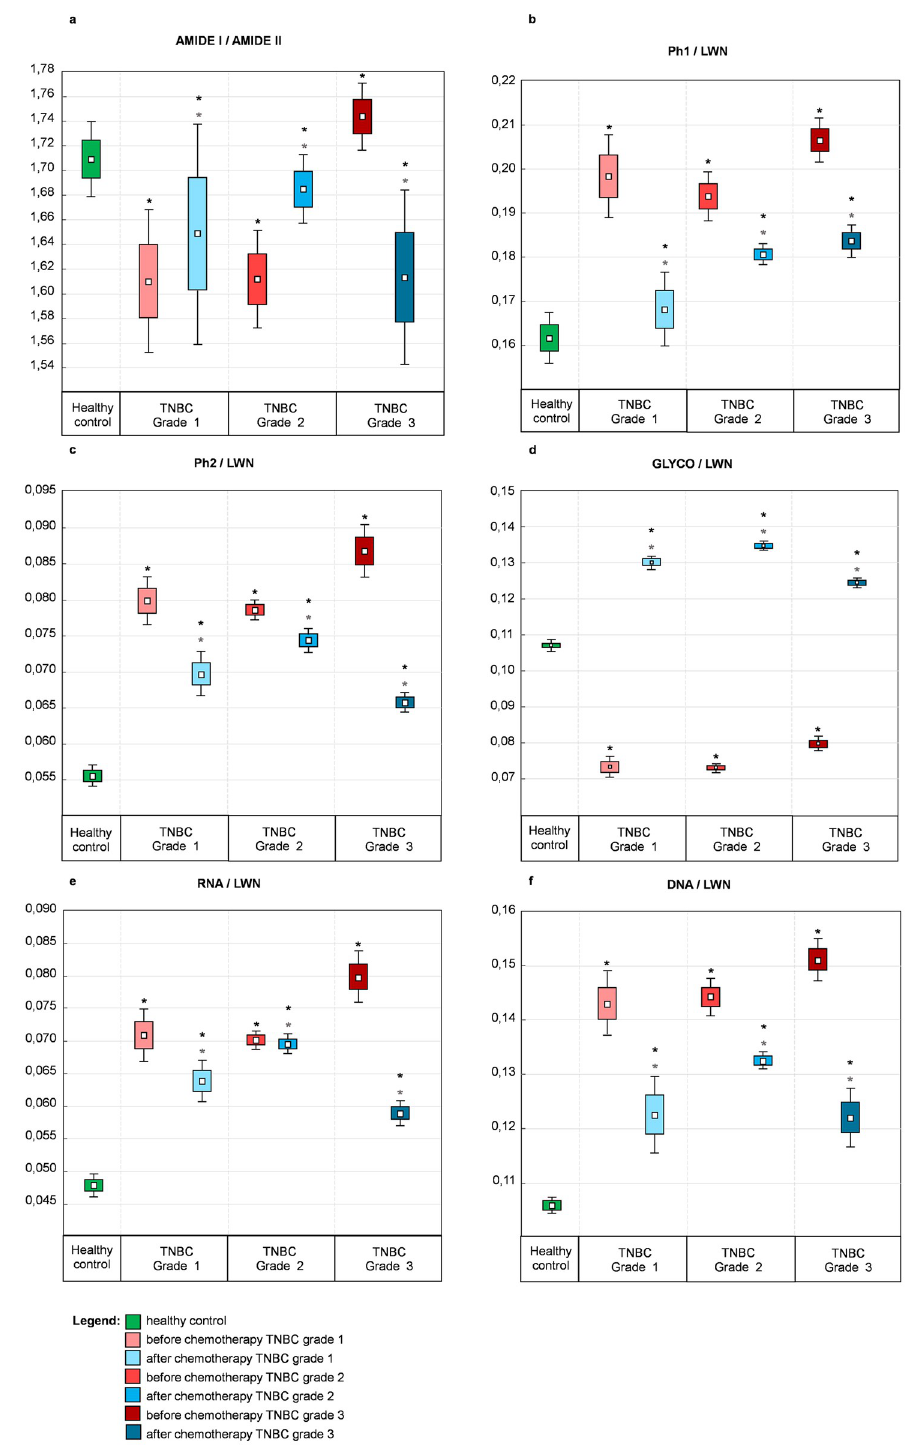
Fig 6. Box charts showing the numerical variation of the band area ratios. Ratios were calculated for healthy control and TNBC grades 1–3: (a) Amide I/Amide II, (b) Ph1/LWN, (c) Ph2/LWN, (d) GLYCO/LWN, (e) RNA/LWN, (f) DNA/LWN. The edges indicate standard deviation, the whiskers indicate standard deviation+1,96 � standard deviation and the white square the mean. Stars over box charts indicate statistically significant difference between healthy control and TNBC patients (top, black) and before versus after chemotherapy (bottom, grey) determined with Wilcoxon test). Statistical significance was set at p < 0,05.